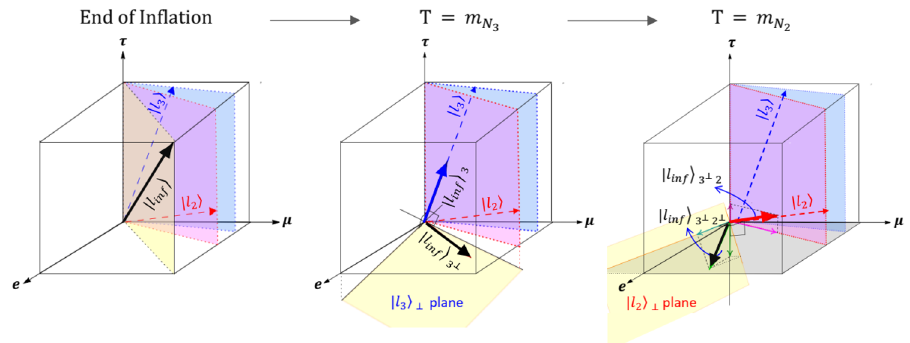
Figure 12 . The geometrical illustration of washout processes induced by the decay of N 3 and N 2 . The left panel shows the SM leptonic states at the end of inflation | l in black and | l in blue inf i 3 , 2 i and red, respectively. The middle panel shows the SM lepton states at T = m and the right N 3 panel presents the system at T = m . The black arrows in each panel show the pre-existing SM N 2 lepton asymmetry, which remains untouched by the washout effects. (Figure adopted from ref.